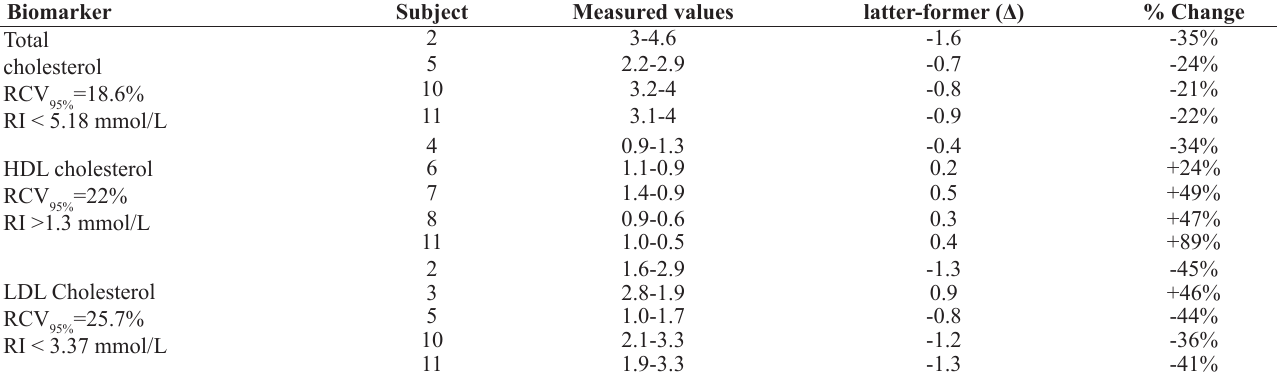
Table 2. Lipid profile evaluated individually before and after two sessions of resistance exercise in women (n = 13). Biomarker Subject Measured values latter-former (Δ) % Change